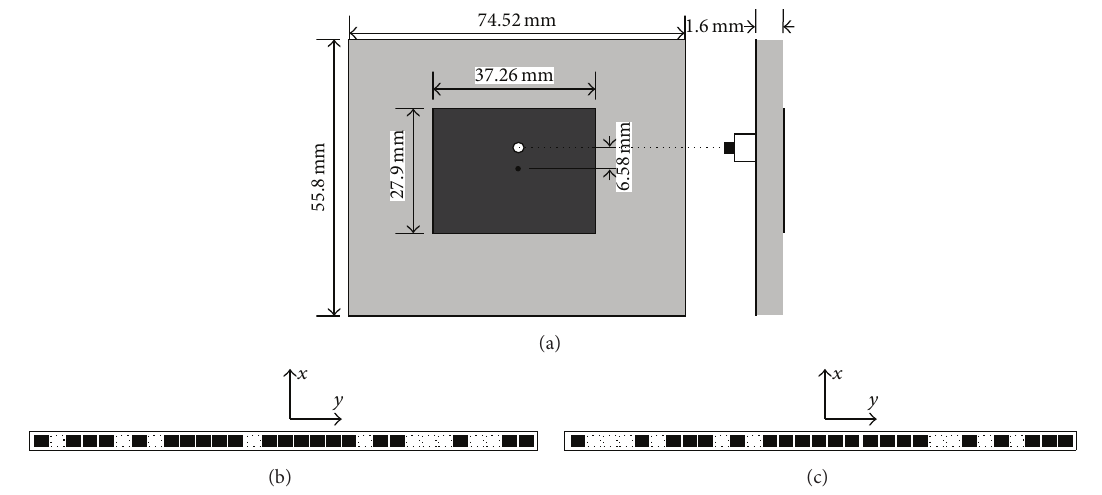
Figure 3: Geometries of linear thinned arrays. (a) Structure of the patch antenna element. (b) Top view of array 1. (c) Top view of array